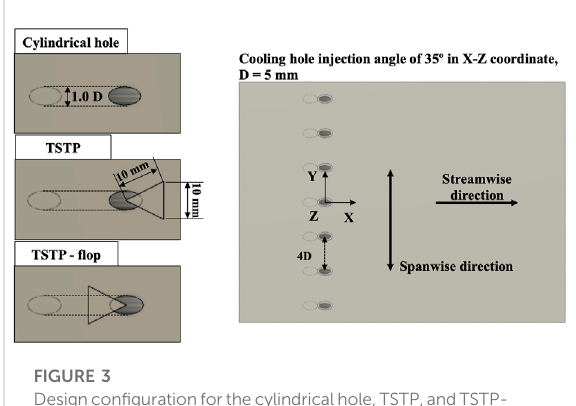
TABLE 1 Experimental parameters and test